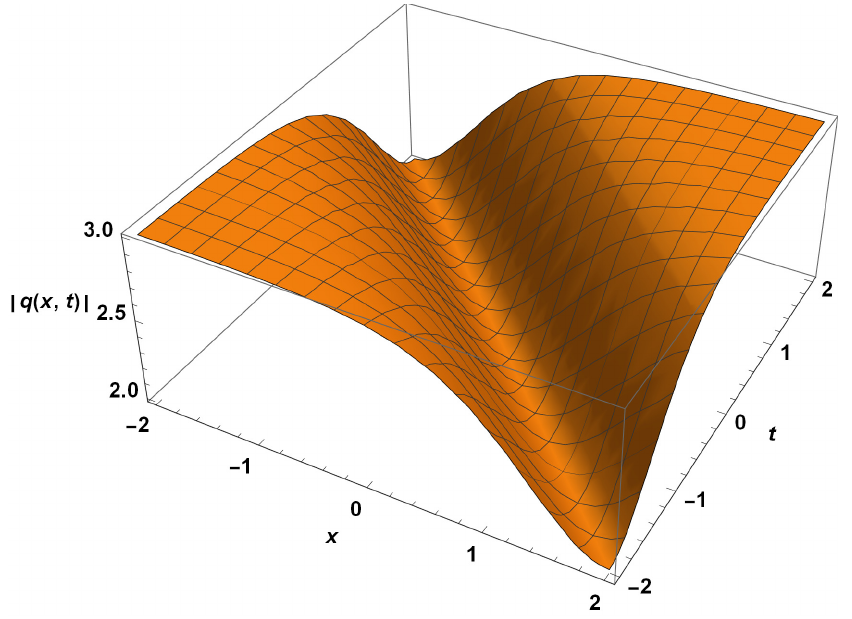
Figure 1. Profile of a dark soliton in fiber Bragg